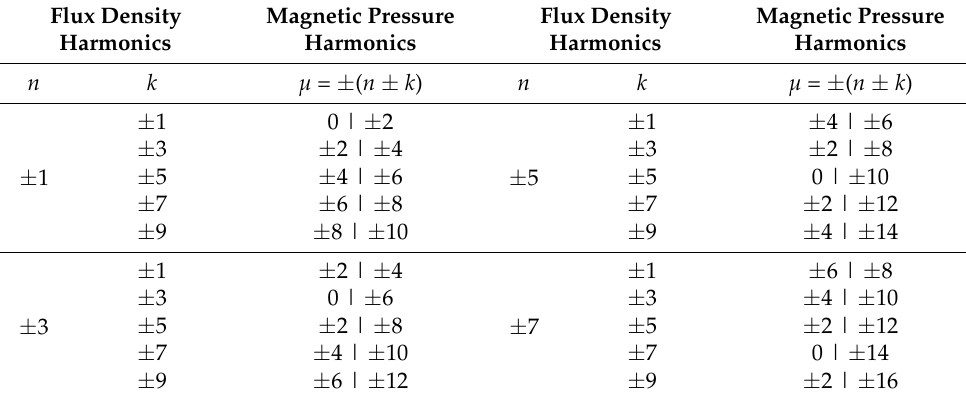
Table 2. Relationship between the harmonics of the flux density and the harmonics of the magnetic pressure on the